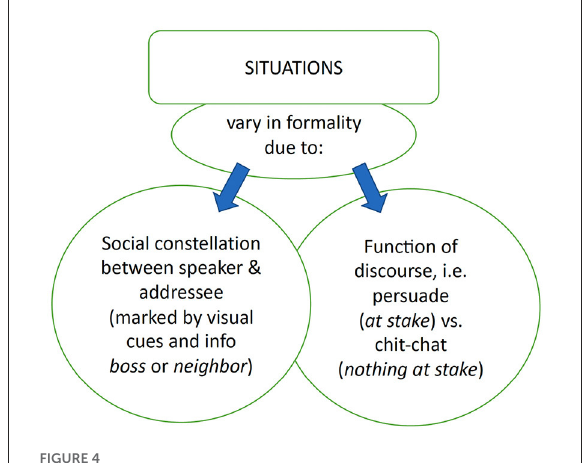
FIGURE4 Project C02: Schematic representation of factors considered within a situation varying in formality.